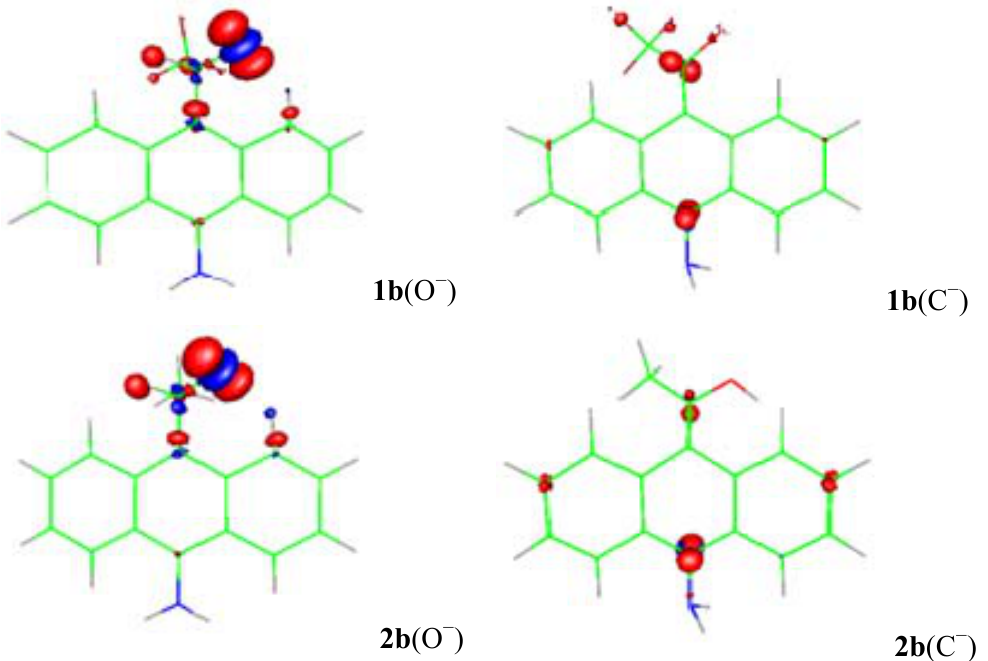
Figure 3. The surface plot of the electrophilic Fukui function for the alkoxides (O − ) and carbanions (C − ) of 1b and 2b